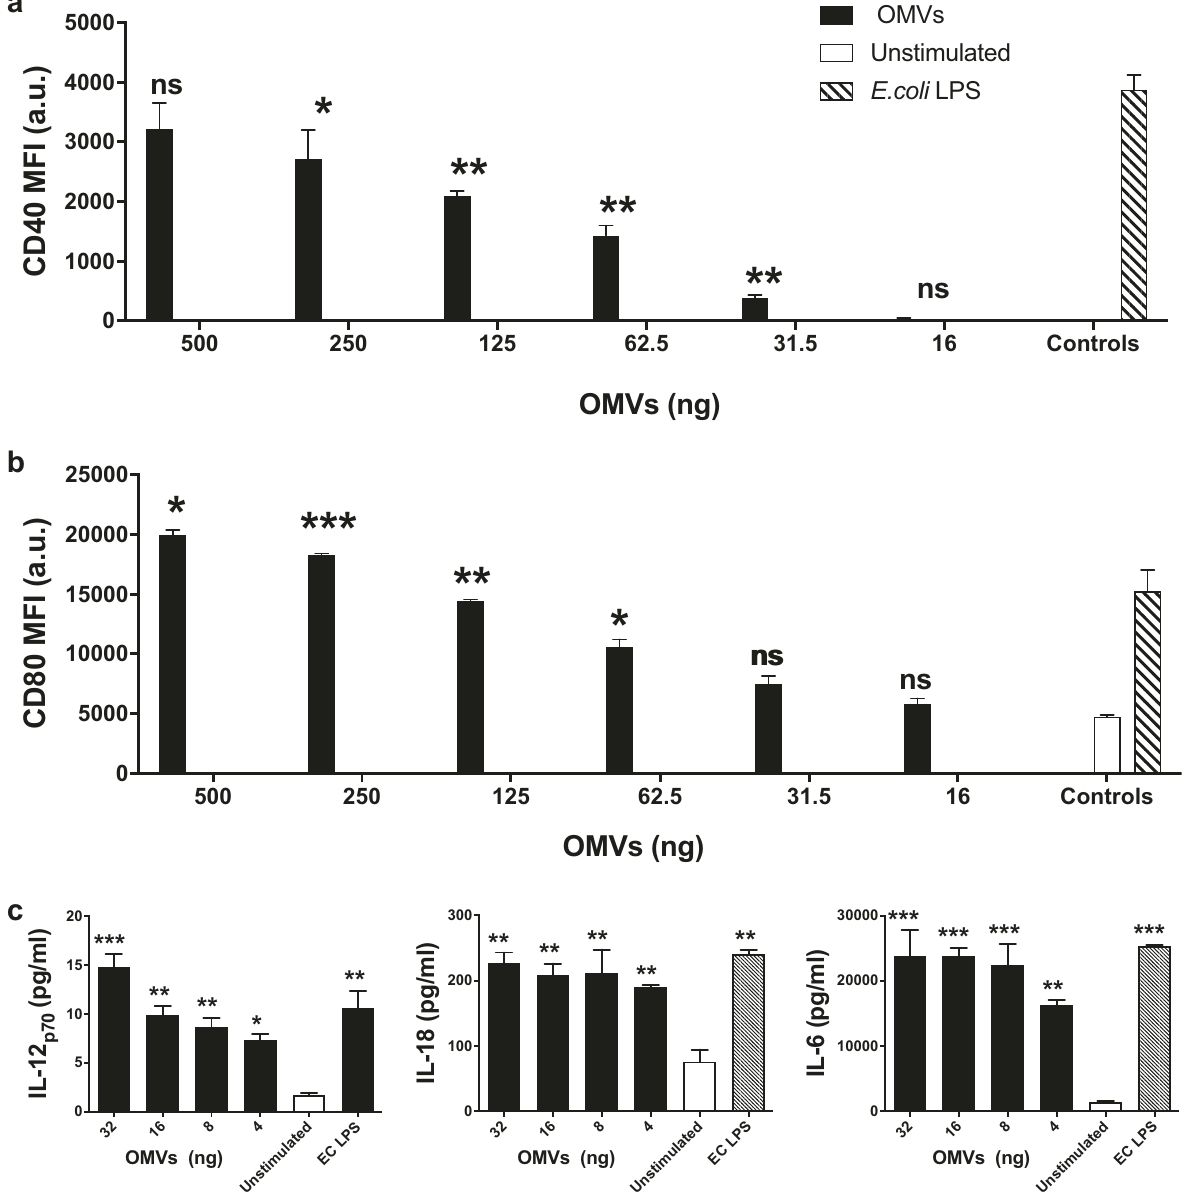
Fig. 6 OMVs activate dendritic cells in vitro. BMDCs were treated with decreasing doses of OMVs or 5 ng/ml E. coli LPS as a positive control or left unstimulated as a negative control for 24 h. Median fl uorescence intensity (MFI) was measured for a CD40 and b CD80 by fl ow cytometry. c Cytokines IL-12p70, IL-18, and IL-6 in the culture supernatants were measured by multiplex assay. ns = not signi fi cant, * p < 0.05, ** p < 0.01, *** p < 0.001 compared to unstimulated by Tukey ’ s multiple comparison test. Results are representative of three independent